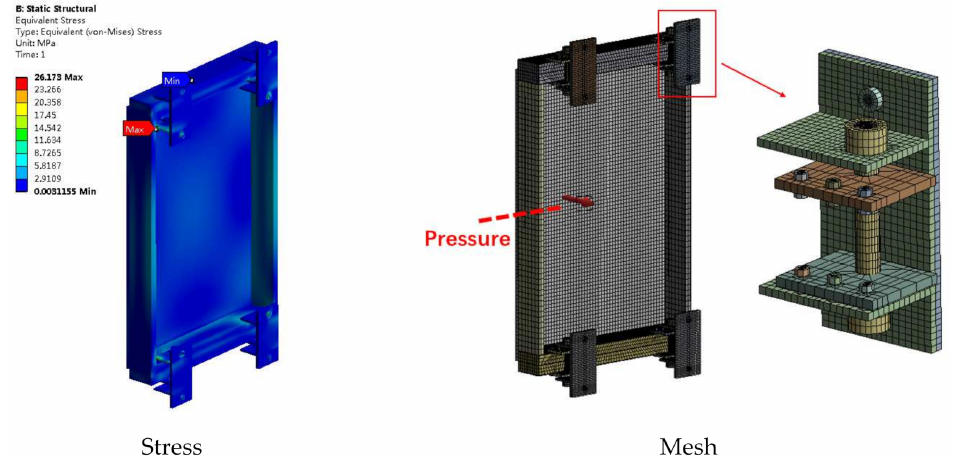
Figure 4. Finite element